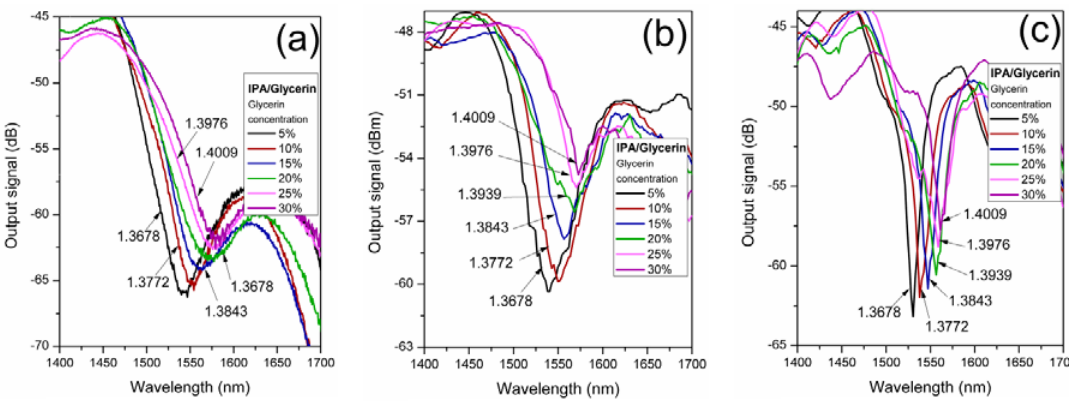
Figure5. TransmittedoutputspectraofthecoatedfiberstructureresponsestoIPA / glycerinconcentration Figure 5. Transmitted output spectra of the coated fiber structure responses to IPA/glycerin variations for: ( a ) sample 1, ( b ) sample 2, and ( c ) sample 3. concentration variations for: ( a ) sample 1, ( b ) sample 2, and ( c ) sample 3.